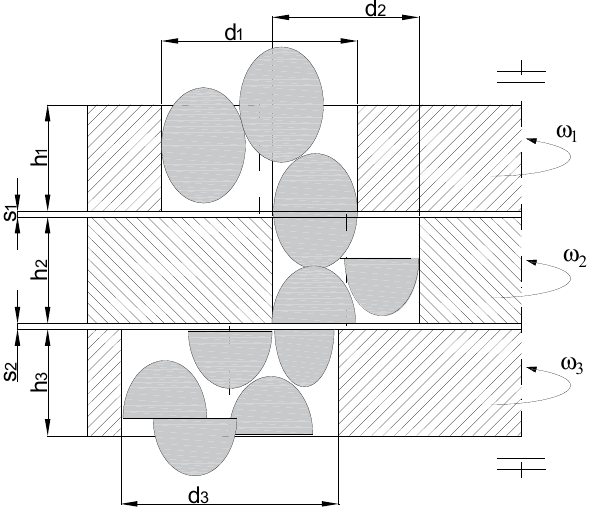
Figure 11. Model of quasi-cutting, d 1 , d 2 , d 3 —holes diameters, h 1 , h 2 , h 3 —disc height, s 1 —inter-disc gap, F—force, ω 1 , ω 2 , ω 3 —discs angular velocities [106].